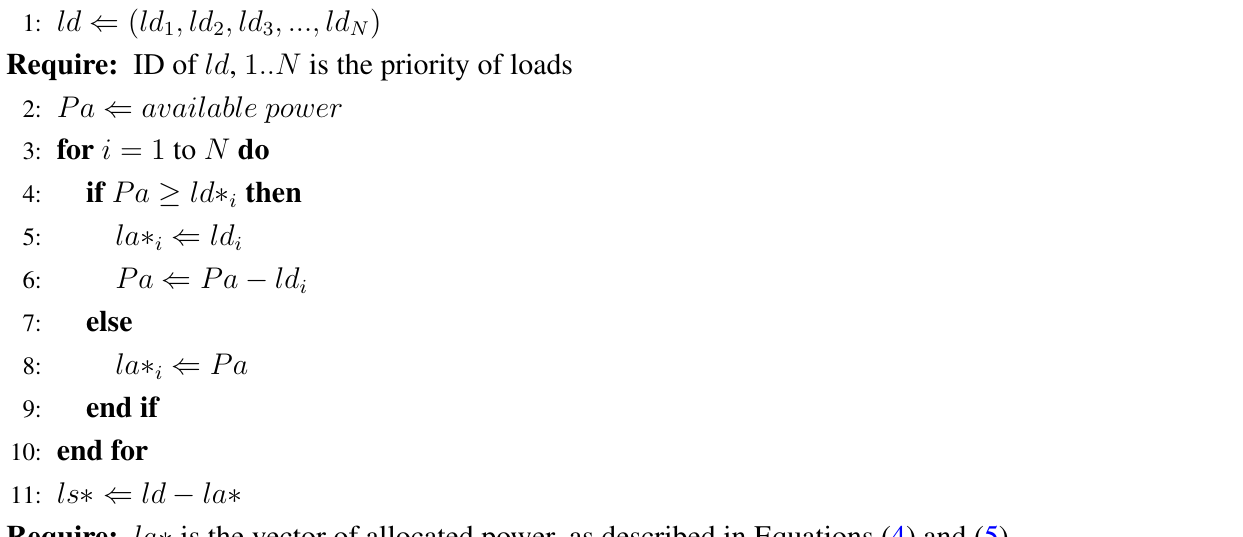
Algorithm 3 Existing priority-based load shedding